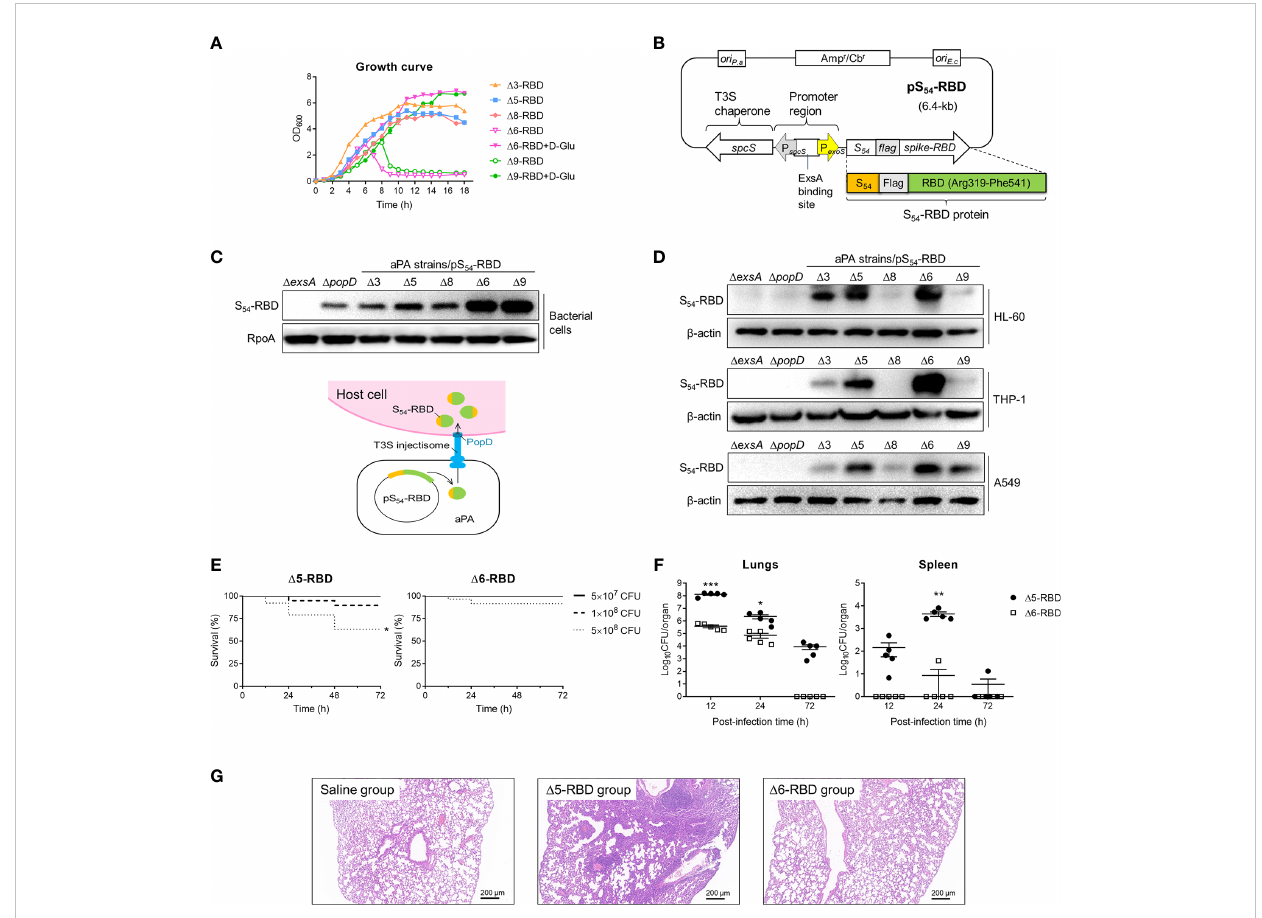
FIGURE 1 Construction and toxicity of candidate aPA-RBD vaccines against SARS-CoV-2. (A) Growth and viability of indicated attenuated P. aeruginosa (aPA) strains in LB liquid medium. D-Glu corresponds to 10 mM D-glutamate. (B) Expression vector of SARS-CoV-2 Spike-RBD fusing with the T3SS secretion signal S 54 and a Flag tag on the N-terminal. ExsA is the master regulator for P. aeruginosa T3SS. (C) Identi fi cation of the fusion protein. Under 5 mM EGTA inducing conditions, aPA-RBD strains were examined for the ability to express the fusion protein by anti ‐ Flag immunoblot of the bacterial pellets. Antibacterial RpoA (bacterial RNA polymerase subunit) immunoblot was used as the bacterial internal reference. (D) Ability of bacterially injection. Human alveolar basal epithelial cell line A549, promyelocytic cell line HL-60, and monocytic cell line THP-1 were cocultured with indicated P. aeruginosa strains for 3 hours at MOI of 100, lysed and examined for protein injection by anti ‐ Flag immunoblot. b -actin was used as the internal reference of mammalian cells. (E) Mice survival after intranasal administration with different amounts of D 5-RBD and D 6-RBD strains. CFU, colony ‐ forming unit. Survival curves are generated by the Log-rank (Mantel-Cox) test to determine the statistical signi fi cance; *, P <0.05. (F) Bacterial loads in lungs and spleen from mice after vaccination with D 5-RBD or D 6- RBD strain (5 × 10 8 CFU per mouse). Comparisons between D 5-RBD and D 6-RBD infected groups were performed by Student ’ s t -test (unpaired, two-tail); Error bars represent SD. *, P < 0.05; **, P < 0.01; ***, P < 0.001. (G) Hematoxylin and eosin (HE) staining of lung tissues collected at day 7 from immunized mouse. Scale bar = 200 m